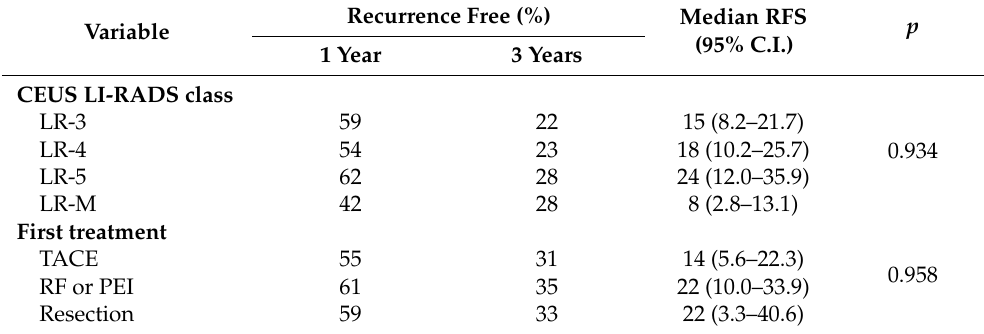
Table 5. Recurrence-free survival in different CEUS LI-RADS classes and different first treatments.